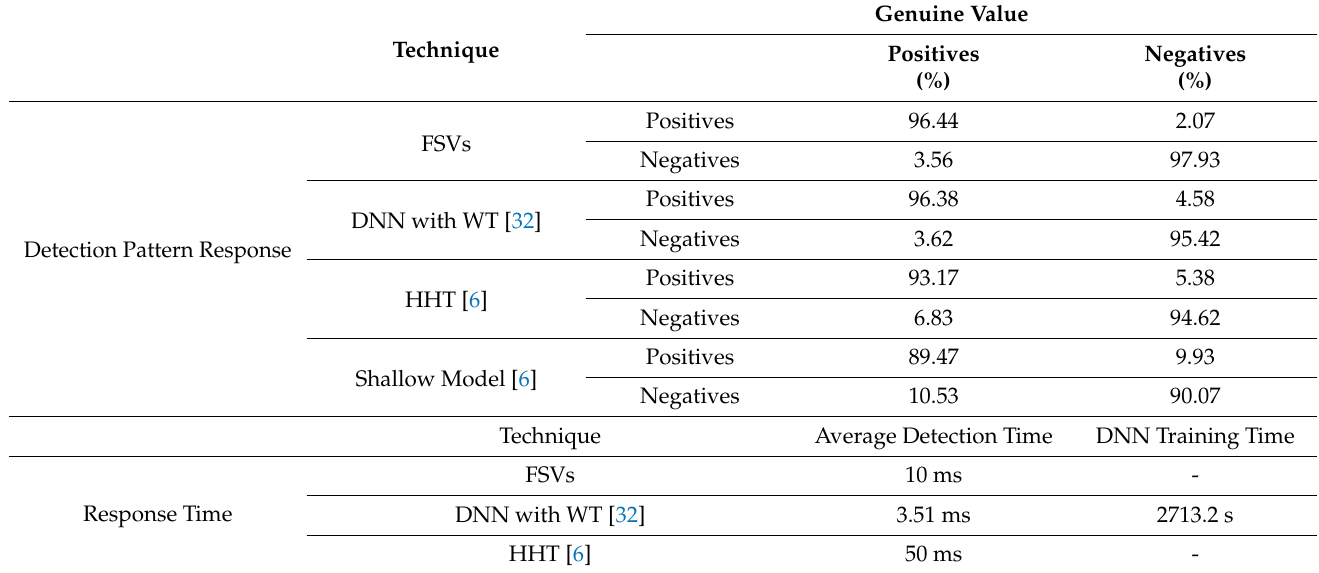
Table 5. Confusion matrix results and